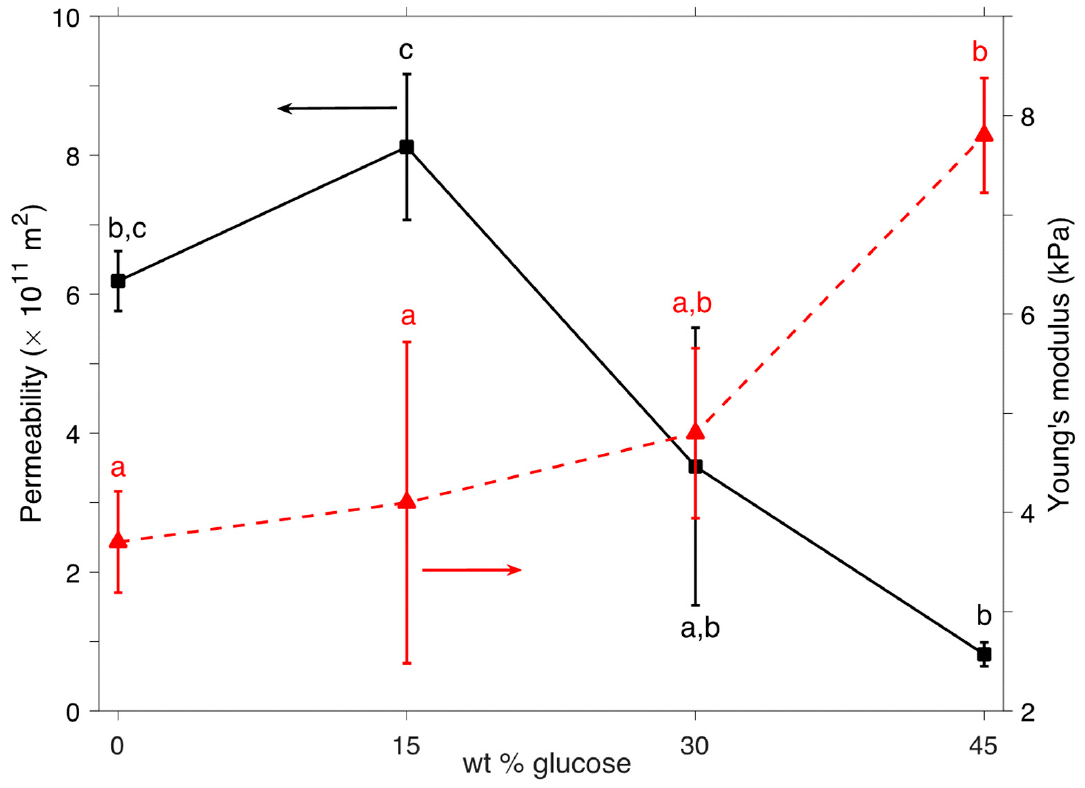
Figure 6. Young’s modulus, E (red triangles), and effective permeability, k /( φ f ) 2 (black squares) extracted from the compression–relaxation experiments through the model in Equations (7) to (11). Error bars represent the standard deviation of three replicate measurements. Different letters represent significant differences ( p <0.05).